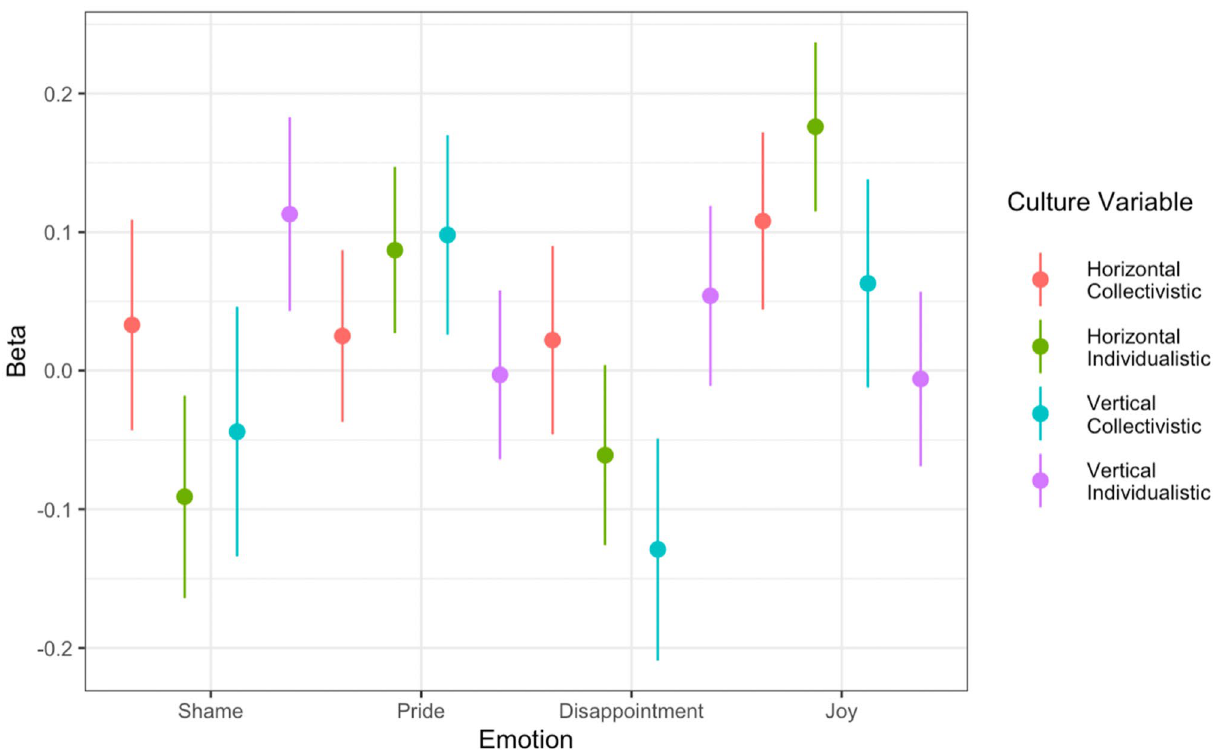
represent + /− 1 standard error.